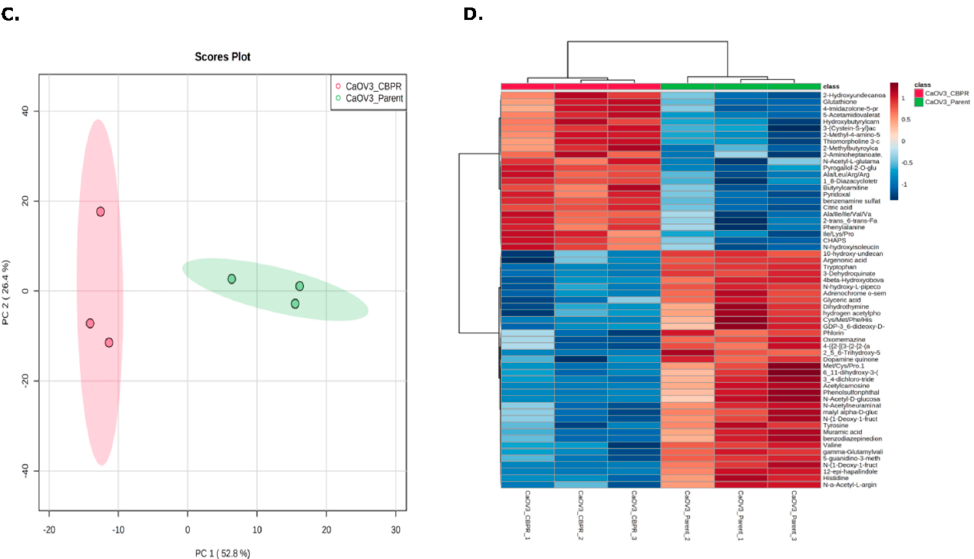
Figure 3. Principle component analysis (PCA) and hierarchical clustering of top 50 differentially abundant metabolites (identified through t -test) between parental (green) and the CBPR (red) cancer cell lines ( A , B ) OVCAR-5 and ( C , D ) CaOV3. Analysis was performed with Metaboanalyst.